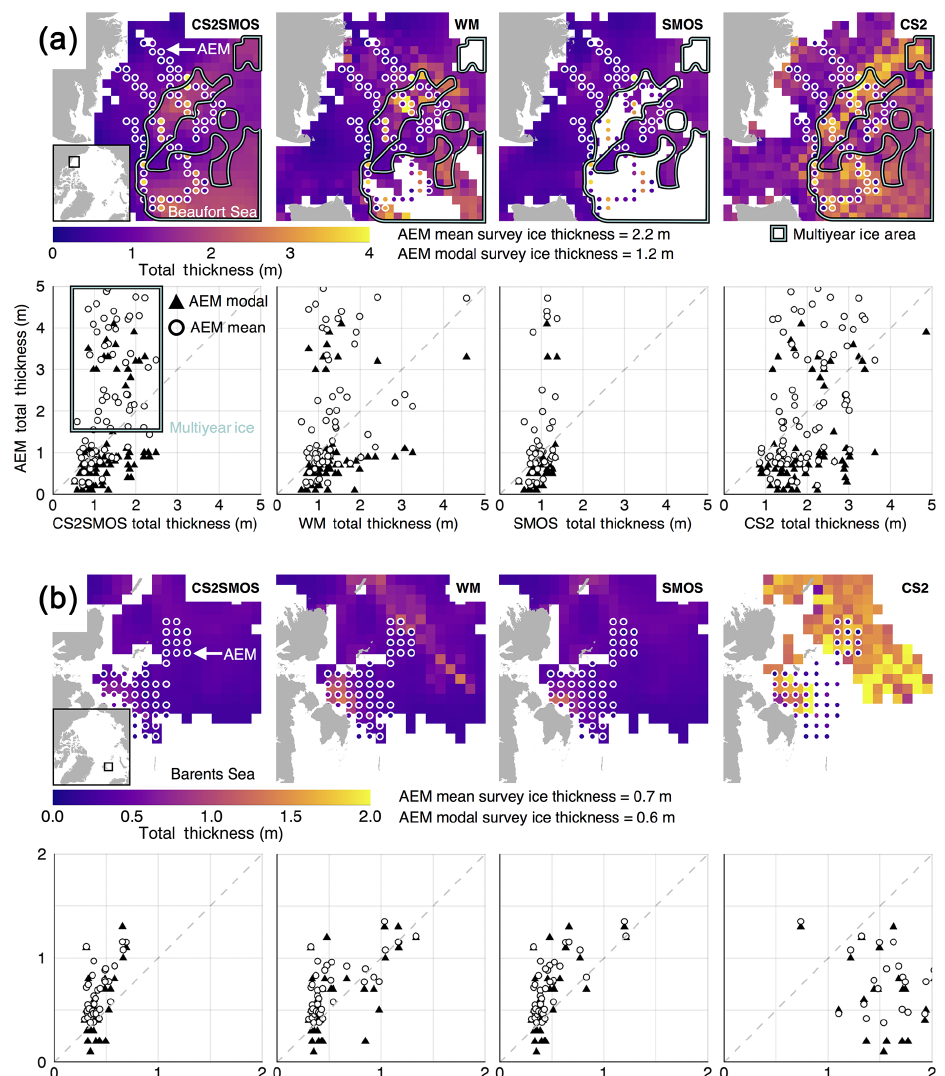
Figure 13. Comparison of satellite retrievals with airborne EM thickness measurements (AEM) over a mixed first-year and multiyear ice regime in the Beaufort Sea in April 2016 (a) and over thin ice in the Barents Sea east of Spitsbergen in March 2014 (b) . AEM data are compared with the optimal interpolation product (CS2SMOS), the weighted mean (WM), the SMOS retrieval and the monthly CryoSat-2 thickness retrieval (CS2). AEM measurements are averaged on the 25km EASE2 grid, providing mean and modal total thickness within a grid cell. AEM measurements in the scatter plots are capped at 5m, while in (a) one mean AEM grid value exceeds the